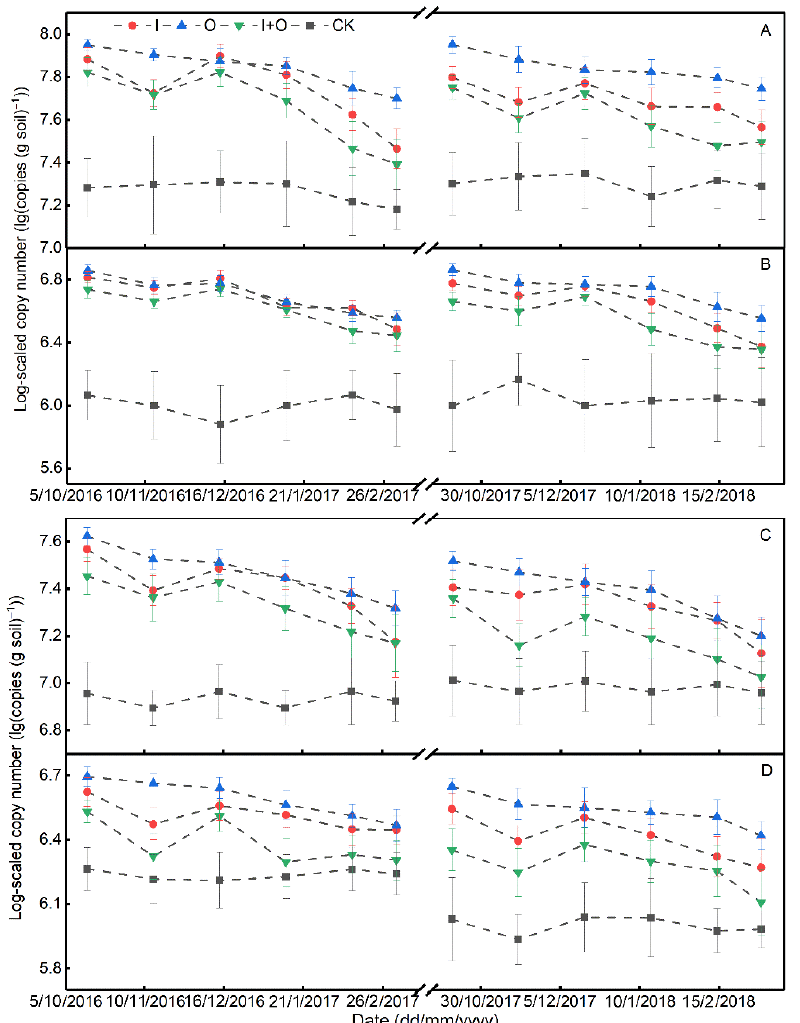
Figure 4. The abundance of nitrifier genes, including AOB-amoA ( A ) and AOA-amoA ( B ), and denitrifier genes including nirK ( C ) and nirS ( D ) at log-scale in soil under different treatments throughout two growing seasons of purple caitai. Different letters indicate significant differences at the level of 0.05. AOB, ammonia-oxidizing bacteria; AOA ammonia-oxidizing archaea; I, inorganic N fertilization; O, organic N fertilization; I+O, integrated organic/inorganic N fertilization; CK, no fertilization.